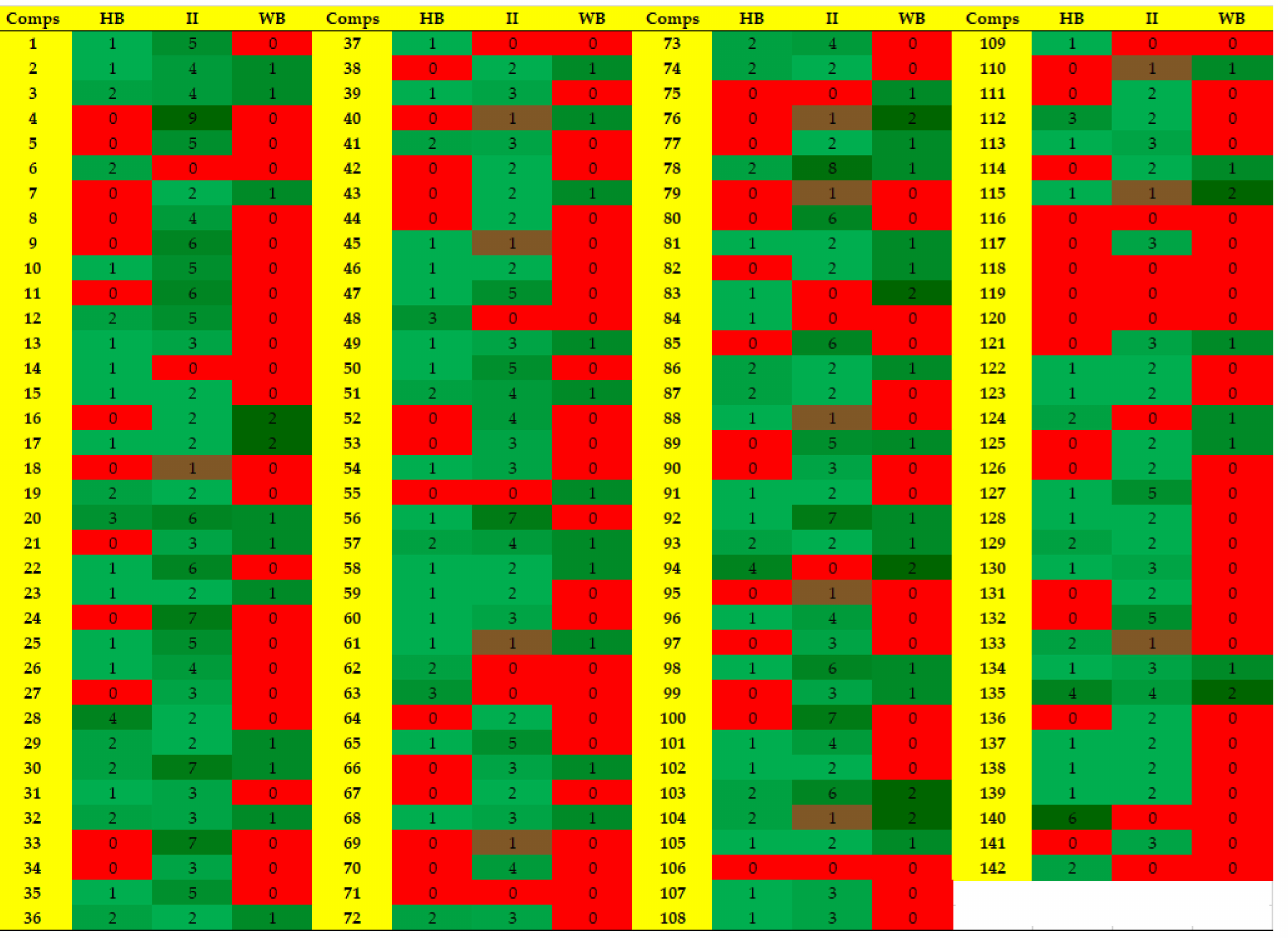
Figure 4. The predicted interaction pattern of compounds 1 – 142. The binding interactions are shown in 3-color-scale (green through red colour scheme) where red and green indicates least and high number of bonds, respectively, HB = Hydrogen bonds, II = ionic interactions, WB = water